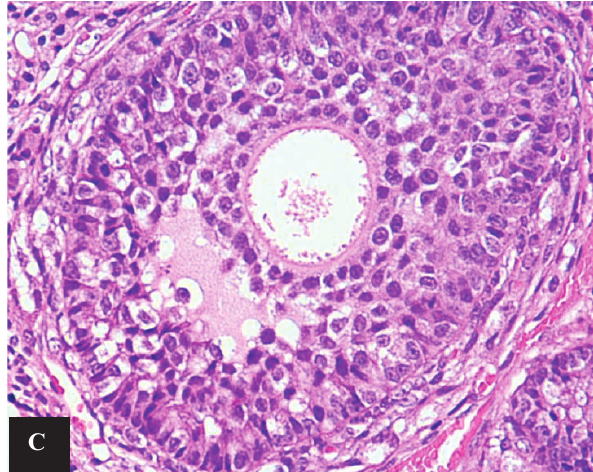
Fig-2C: Secondary follicle of rat experimental group C showing normal structure (H&E, 20x).